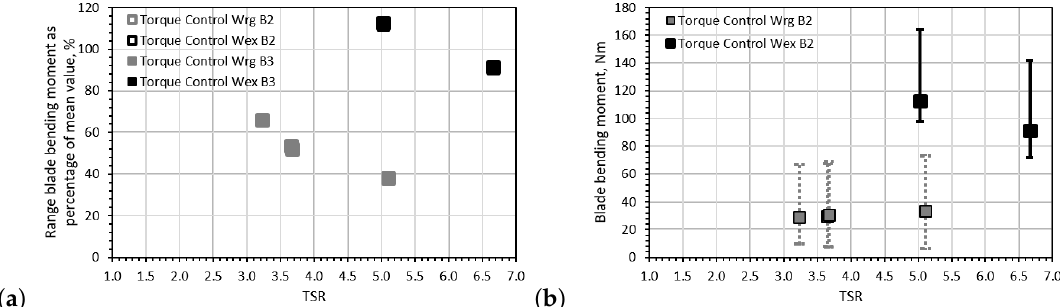
Figure 13. Average bending root moment fluctuations per wave period only for torque control cases: ( a ) the bending root moment fluctuation range as a percentage of the mean bending moment for each blade is presented and ( b ) the average maximum and minimum rotor thrust per wave period are indicated by the extremes of the error bars (only for blade 2).